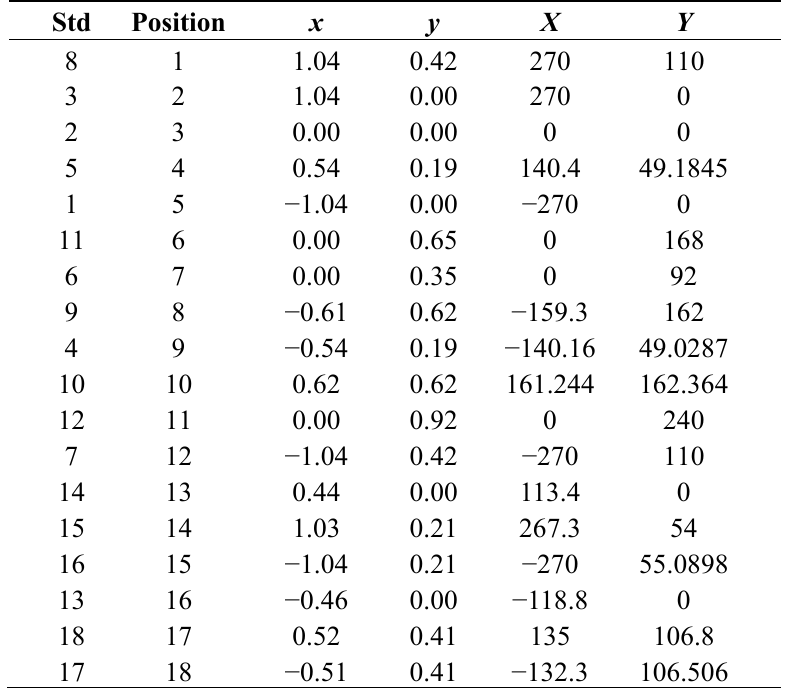
Table 2. List of sampling positions of tracer gas experiment, by IV optimal design from software Design Expert ver. 8. Std is the descending order of the standard error of the corresponding position. x,y and X,Y are the dimensionless and actual coordinates of the positions, respectively.